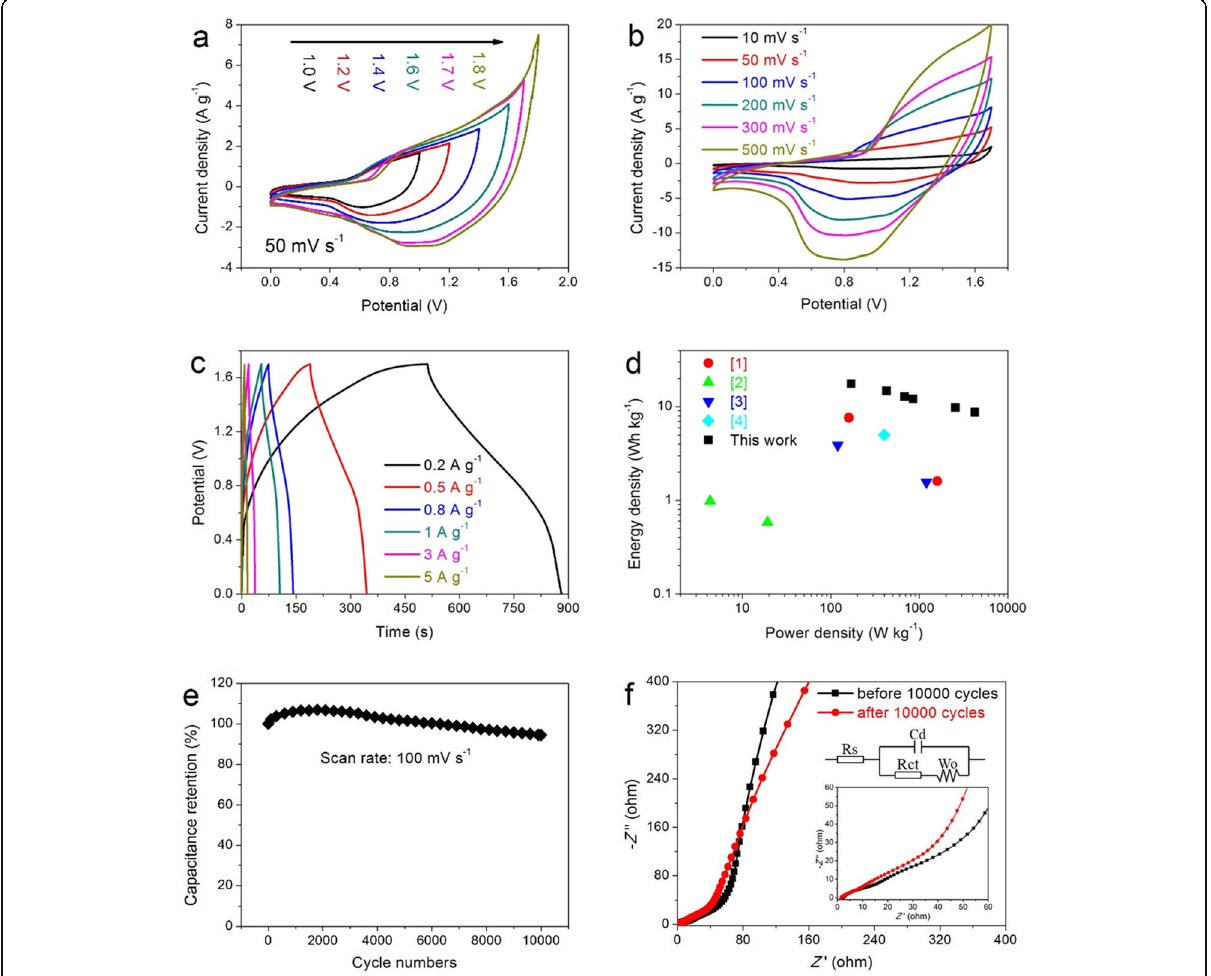
Fig. 8 Electrochemical performances of rGO@LCO//rGO asymmetric supercapacitor system (ASS) in 6 M KOH electrolyte: a CV curves at various potential windows from 0 – 1.0 to 0 – 1.8 V with a scan rate of 50 mV s − 1 . b CV curves. c GCD curves. d Ragone plot. e Cycle stability at 100 mV s − 1 for 10,000 cycles. f Nyquist plots of rGO@LCO//rGO ASS before and after 10000